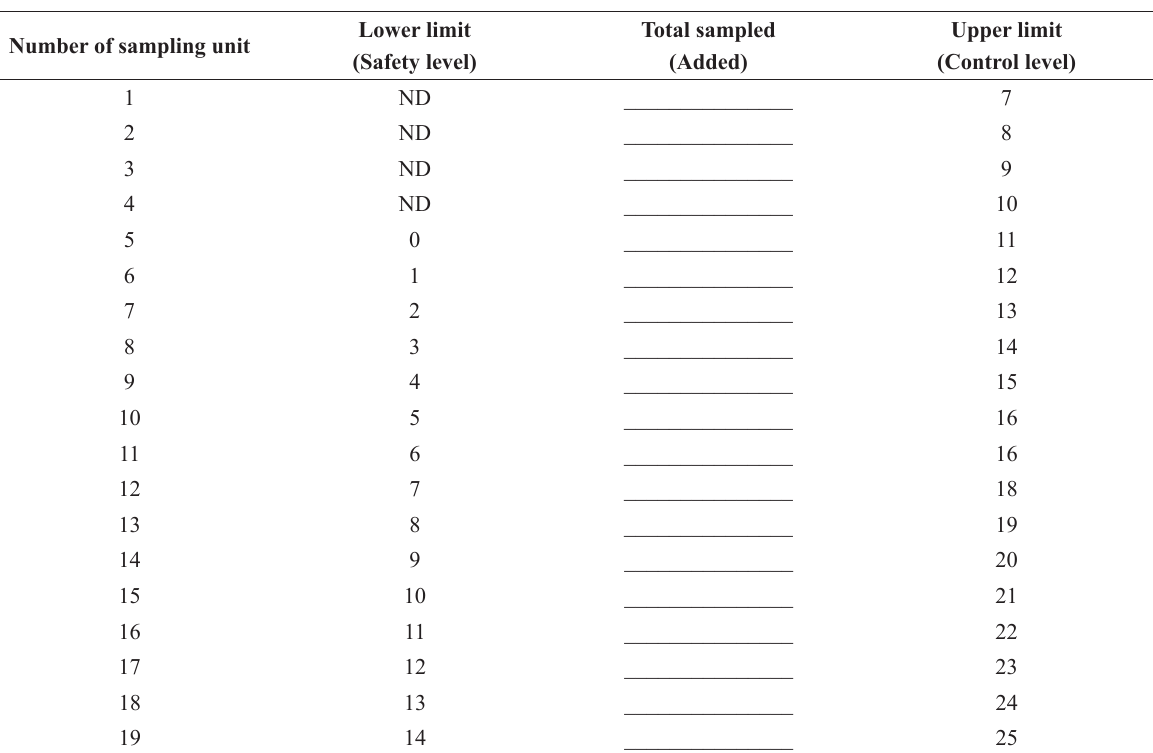
Field worksheet for sequential sampling, aiming to evaluate the infestation by fruit fly species of the genus Anastrepha in three orchards of ‘Novo Milênio’ guava cultivar for 23 weeks in three sites in the municipality of Ivinhema, State of Mato Grosso do Sul, Brazil (August 2013 to January